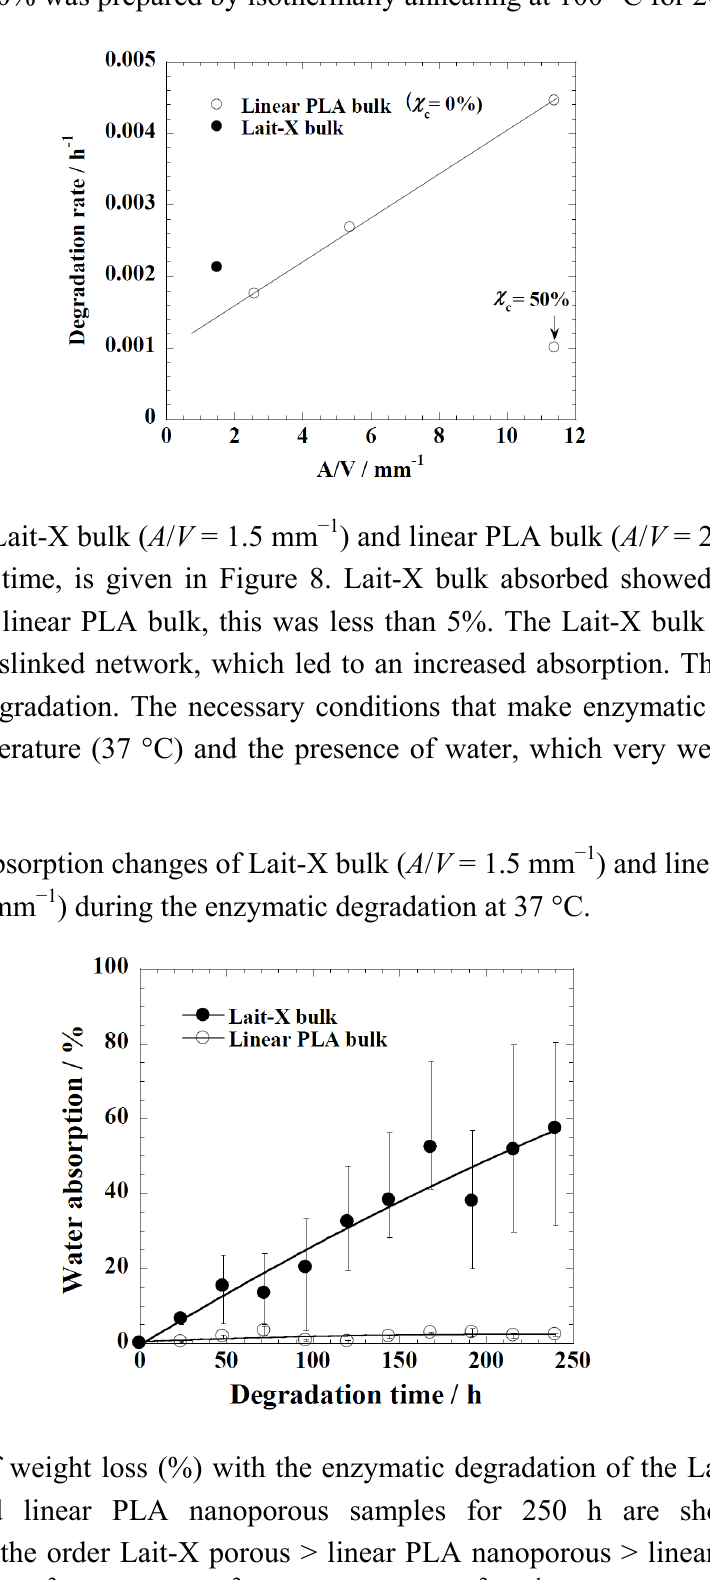
Figure 7. The degradation rate of linear polylactide (PLA) and Lait-X bulk. The linear PLA having χ = 50% was prepared by isothermally annealing at 100 °C for 20 min [15]. c